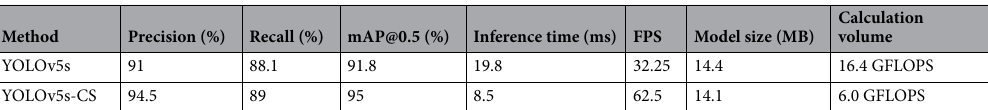
Table 6. Results of network performance testing of the network model with the original network model by introducing the attention combination mechanism.